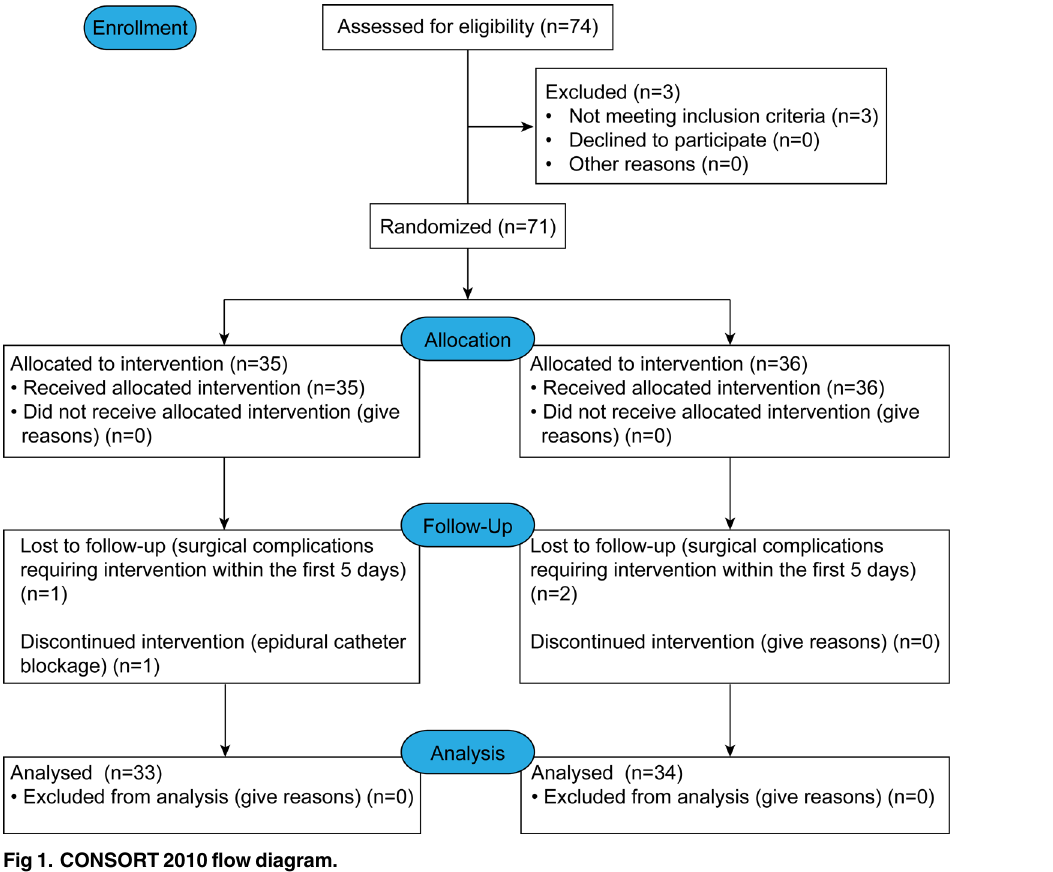
Fig 1. CONSORT 2010 flow diagram.